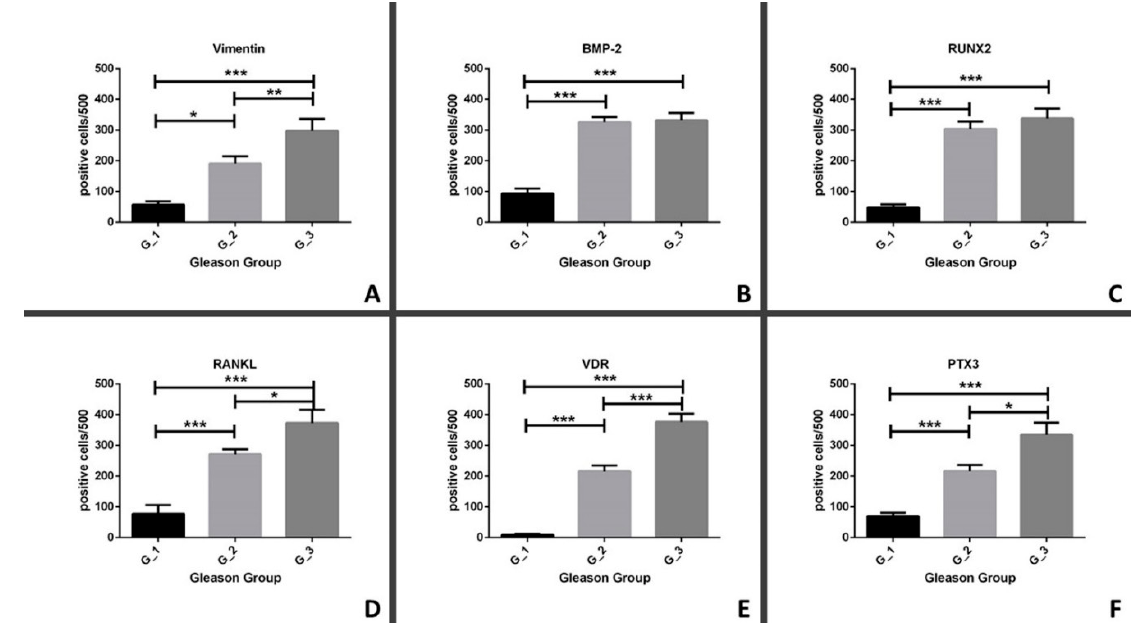
Figure 3. Comparison between Gleason Group and the expression of bone biomarkers. ( A ) The graph shows the number of vimentin-positive cancer cells in G_1, G_2, and G_3. ( B ) The graph displays the number of BMP-2 positive cancer cells in G_1, G_2, and G_3. ( C ) The graph shows the number of RUNX2 positive cancer cells in G_1, G_2, and G_3. ( D ) The graph displays the number of RANKL positive cancer cells in G_1, G_2, and G_3. ( E ) The graph shows the number of VDR positive cancer cells in G_1, G_2, and G_3. ( F ) The graph displays the number of PTX3 positive cancer cells in G_1, G_2, and G_3. * p < 0.05, ** p < 0.01, *** p <